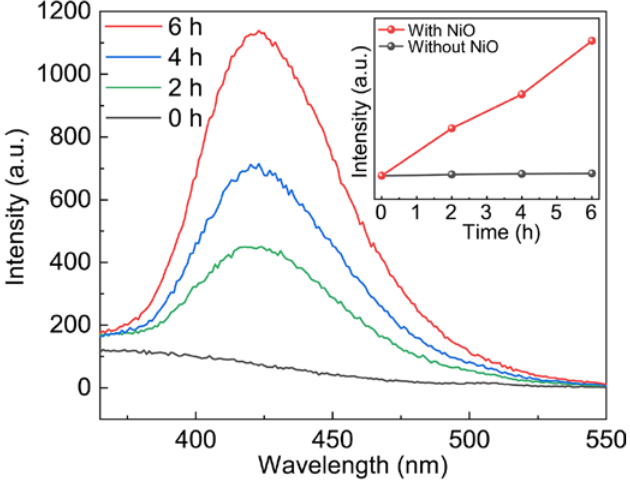
Figure 6. Fluorescence spectra of the 2-hydroxyterephthalic acid solutions taken from a terephthalic acid solution suspended with NiO particles and magnetically stirred (inset: fluorescence intensity of 2-hydroxyterephthalic acid at 425 nm over time).